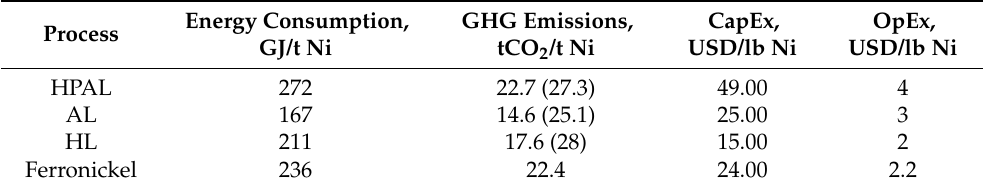
Table 2. Comparison of energy consumption, average carbon dioxide emissions, and capital and operational expenses of the metallurgical operations for nickel production from lateritic ores. Values in brackets for GHG emissions are values for hydrometallurgical operations that do not have acid pro- duction plant on site [21–23]. Abbreviations: HPAL—high-pressure acid leaching, AL—atmospheric pressure tank leaching, HL—heap